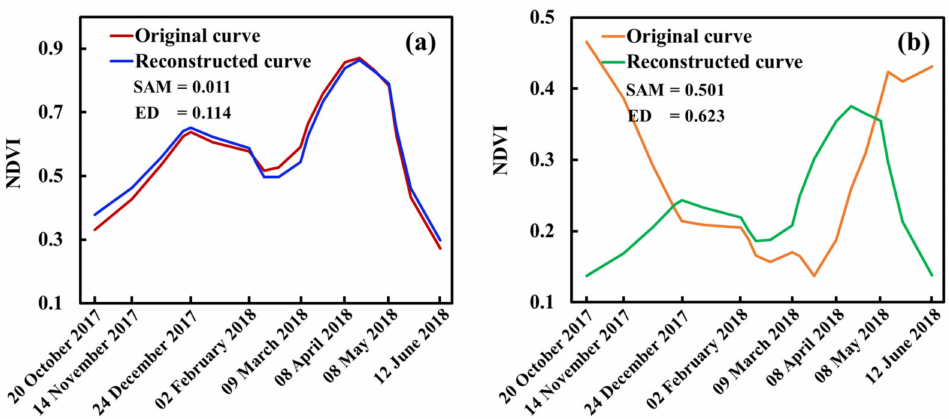
Figure 6. ( a ) Original and reconstructed winter wheat normalized difference vegetation index (NDVI) time series. ( b ) Origi- nal and reconstructed non-winter wheat NDVI time